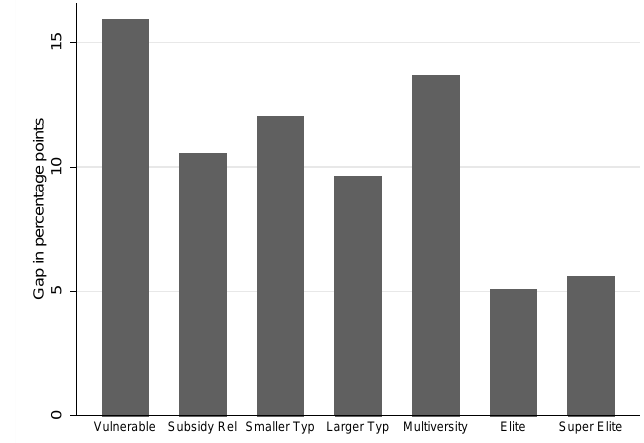
Figure 4. White–Black graduation gap (in percentage points) by institutional